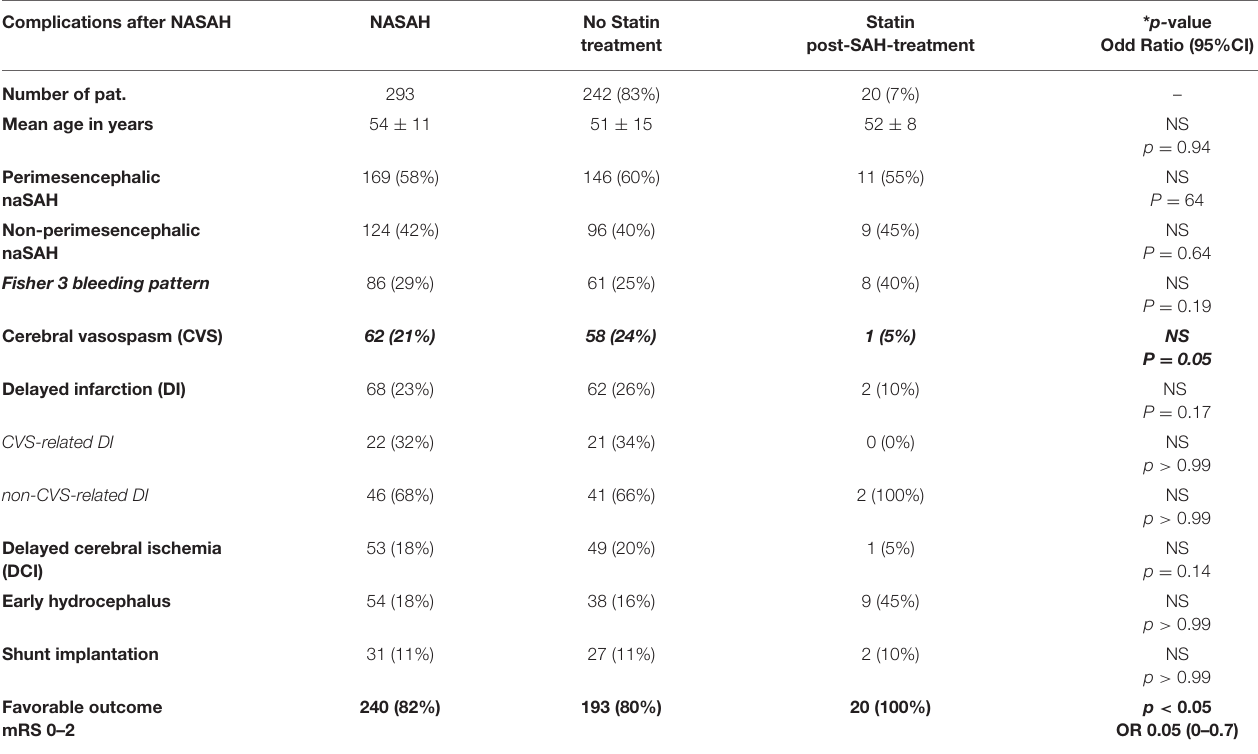
Statin * p- value treatment post-SAH-treatment Odd Ratio (95%CI)